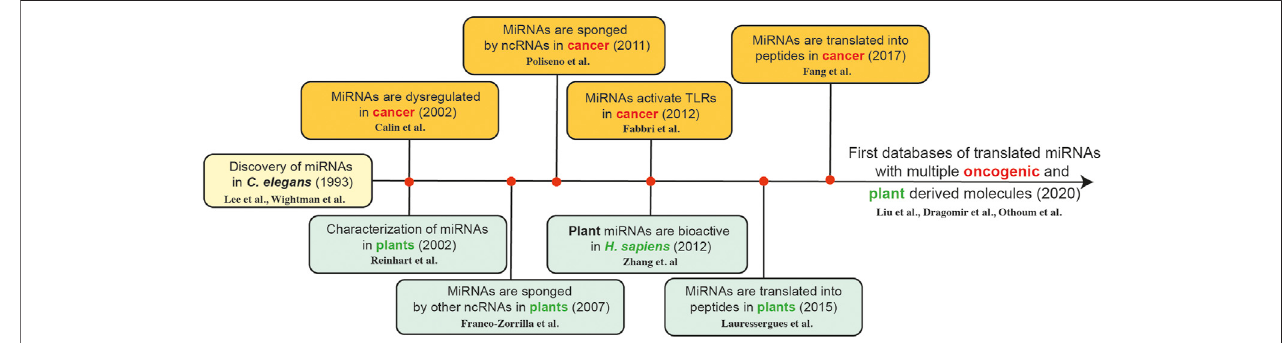
FIGURE1| The timelineofmiRNA discoveriesisrelated plant sciencesand oncology;providing anewunderstandingabout potential newplant based therapeutic tools in cancer therapy [Lee et al. (Lee et al., 1993), Wightman et al. (Wightman et al., 1993), Calin et al. (Calin et al., 2002), Reinhart et al. (Reinhart et al., 2002), Franco- Zorilla et al. (Franco-Zorrilla et al., 2007), Poliseno et al. (Poliseno et al., 2010), Fabbri et al. (Fabbri et al., 2012), Zhang et al. (Zhang et al., 2012), Lauressergues et al. (Lauresserguesetal.,2015),Fangetal.(FangJ.etal.,2017),Liuetal.(LiuH.etal.,2020),Dragomiretal.(Dragomiretal.,2020b),andOthoumetal.(Othoumetal.,